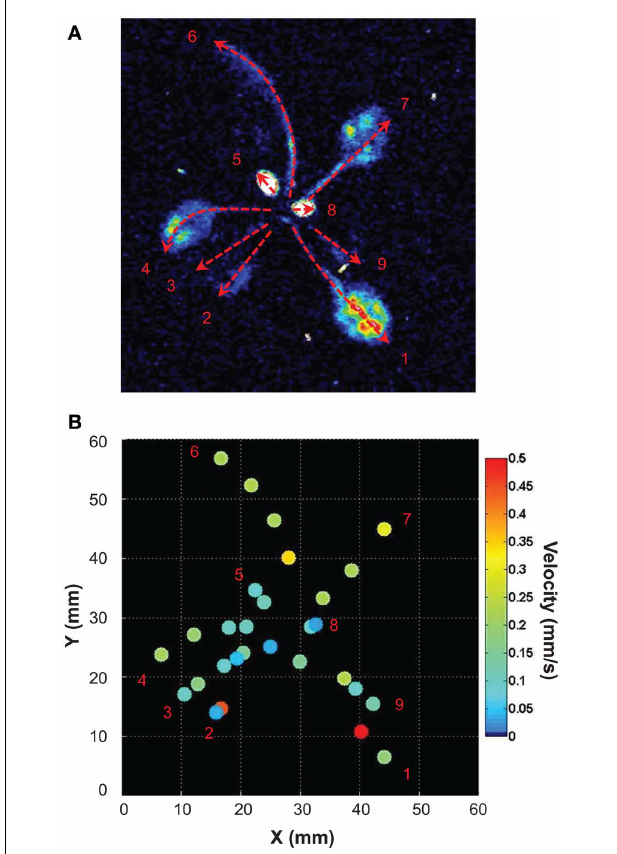
FIGURE 7 | Analysis of the propagation of Ca 2 + elevations induced by high salt stimulus applied to roots. (A) Free Ca 2 + elevations on each leaf were analyzed with ImageJ. Velocities (mm/s) of Ca 2 + responses were determined for each leaf along paths figured by red dashed arrows (values of Ca 2 + response velocity are presented on Table 1 ). (B) Propagation speeds along the main leaf vain are indicated for selected points (same space scale as in A ). False color scale is in mm/s.